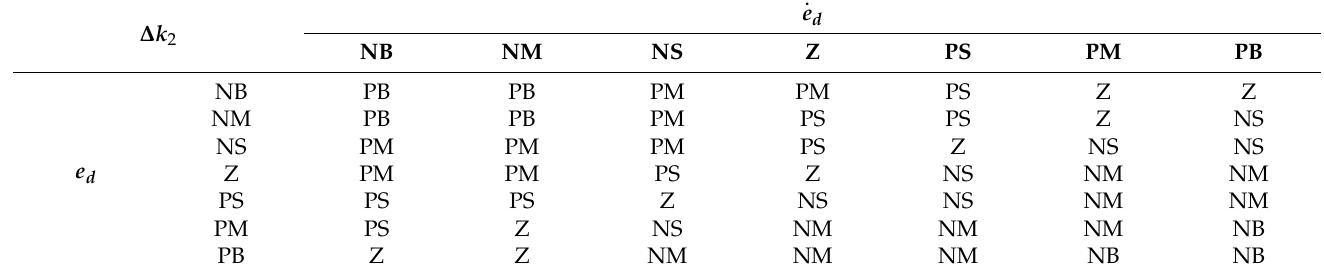
Table 1. Fuzzy rules to estimate ∆ k 2 , based on e d and e d .